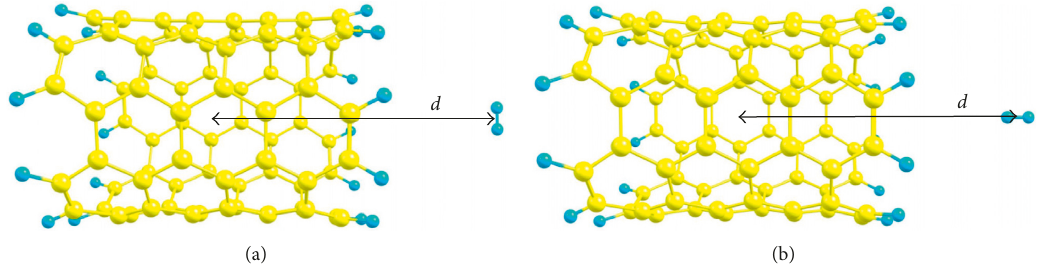
Figure 1: Perpendicular (a) and parallel (b) orientations of an H 2 molecule in relation to the axis of (5,5) SWCNTas an example. Small balls (blue) are hydrogen, and large balls (yellow) are